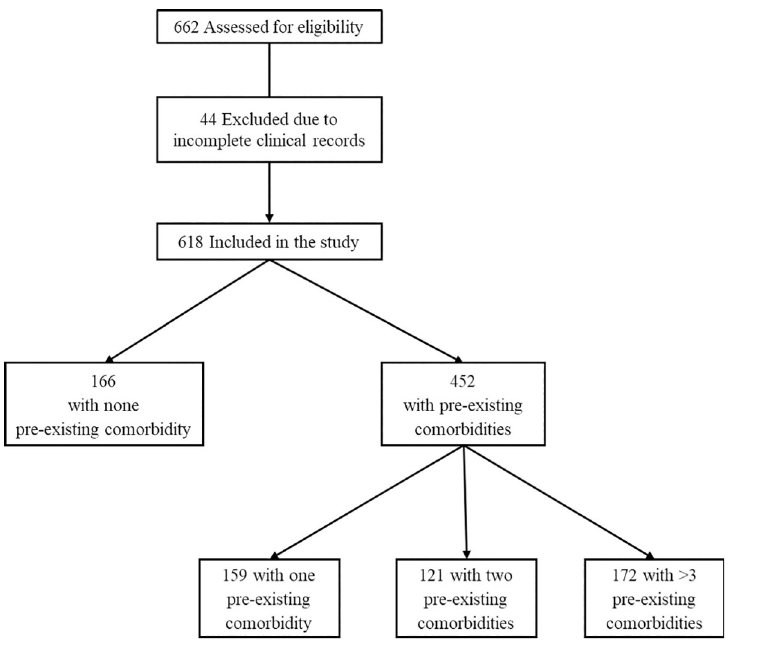
Fig 1. Flow-chart of the